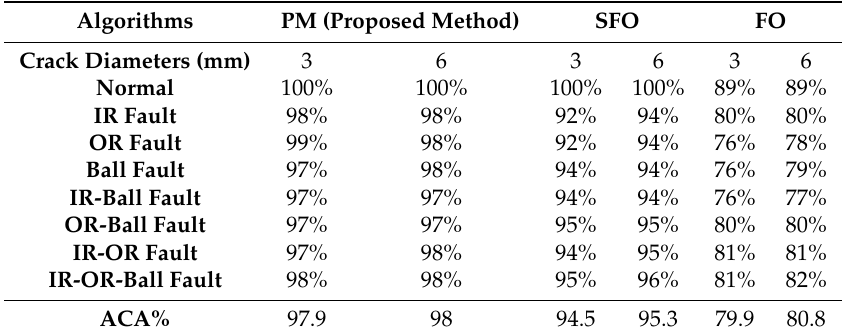
Table 12. The multi-fault diagnosis accuracy for motor speed-variant